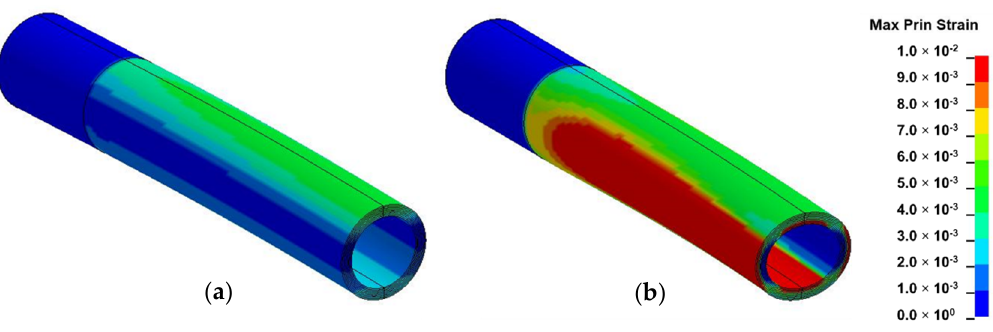
Figure 7. Fringe component of maximum principal strain in: ( a ) homogeneous model; ( b ) inhomogeneous model.